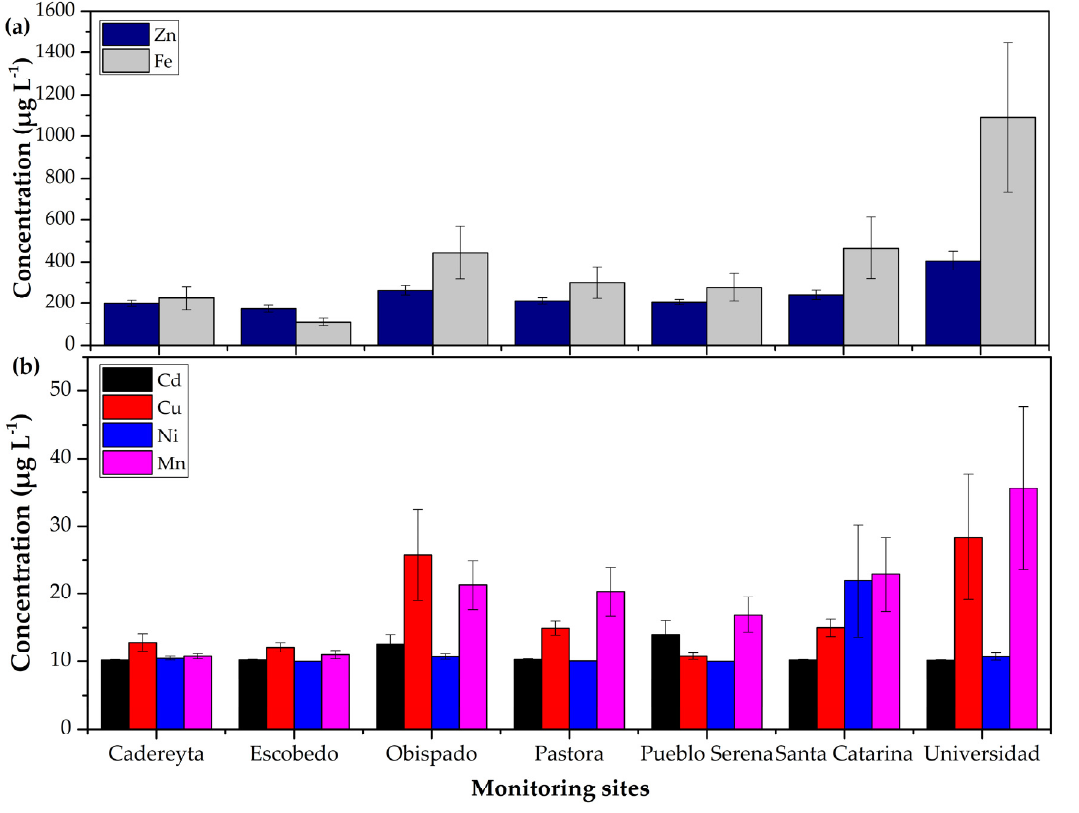
Figure 7. Average concentrations of ( a ) Zn and Fe, ( b ) Cd, Cu, Ni and Mn, for each monitoring site. Plotted data are means ± standard error.